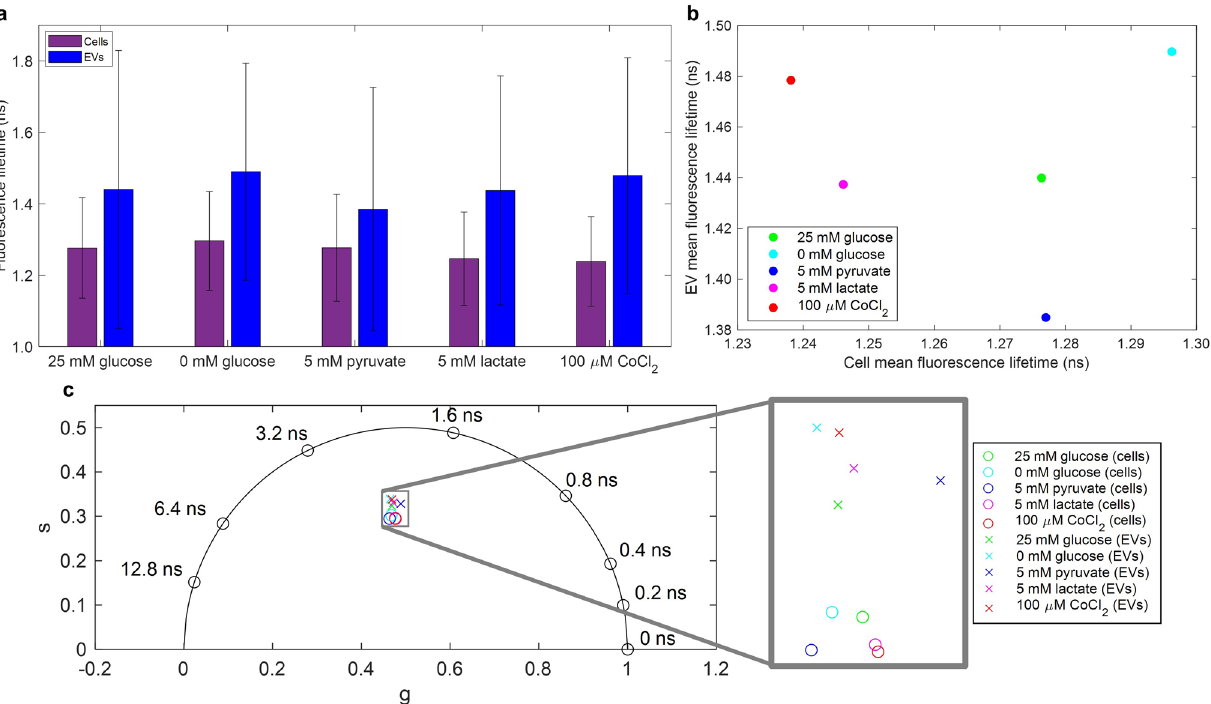
Figure 6. The effect of cellular metabolic conditions on the fluorescence lifetime of cells and cell-derived extracellular vesicles (EVs). ( a ) Mean and standard deviation of fluorescence lifetime values of cells ( purple ) and EVs ( blue ) are indicated in the bar charts for the five experimental conditions; each condition contains pooled data from three independent replications. ( b ) Scatterplot of EV mean fluorescence lifetime vs. cell mean fluorescence lifetime for the five experimental groups: 25 mM glucose ( green ), 0 mM glucose ( cyan ), 5 mM pyruvate ( blue ), 5 mM lactate ( magenta ), and 100 μM CoCl 2 ( red ). ( c ) Phasor components of cell ( o markers ) and EV ( x markers ) mean fluorescence lifetimes. Experimental group is indicated by color as described above. Data from three replicates of each experimental condition is pooled together, and each replicate consisted of 4 fields-of-view (FOVs) for cells and 16 FOVs for EVs. The total number of vesicles (n) for each experimental group pooled together is as follows: 25 mM glucose n = 629, 0 mM glucose n = 2003, 5 mM pyruvate n = 864, 5 mM lactate n = 1668, 100 µM CoCl 2 n =